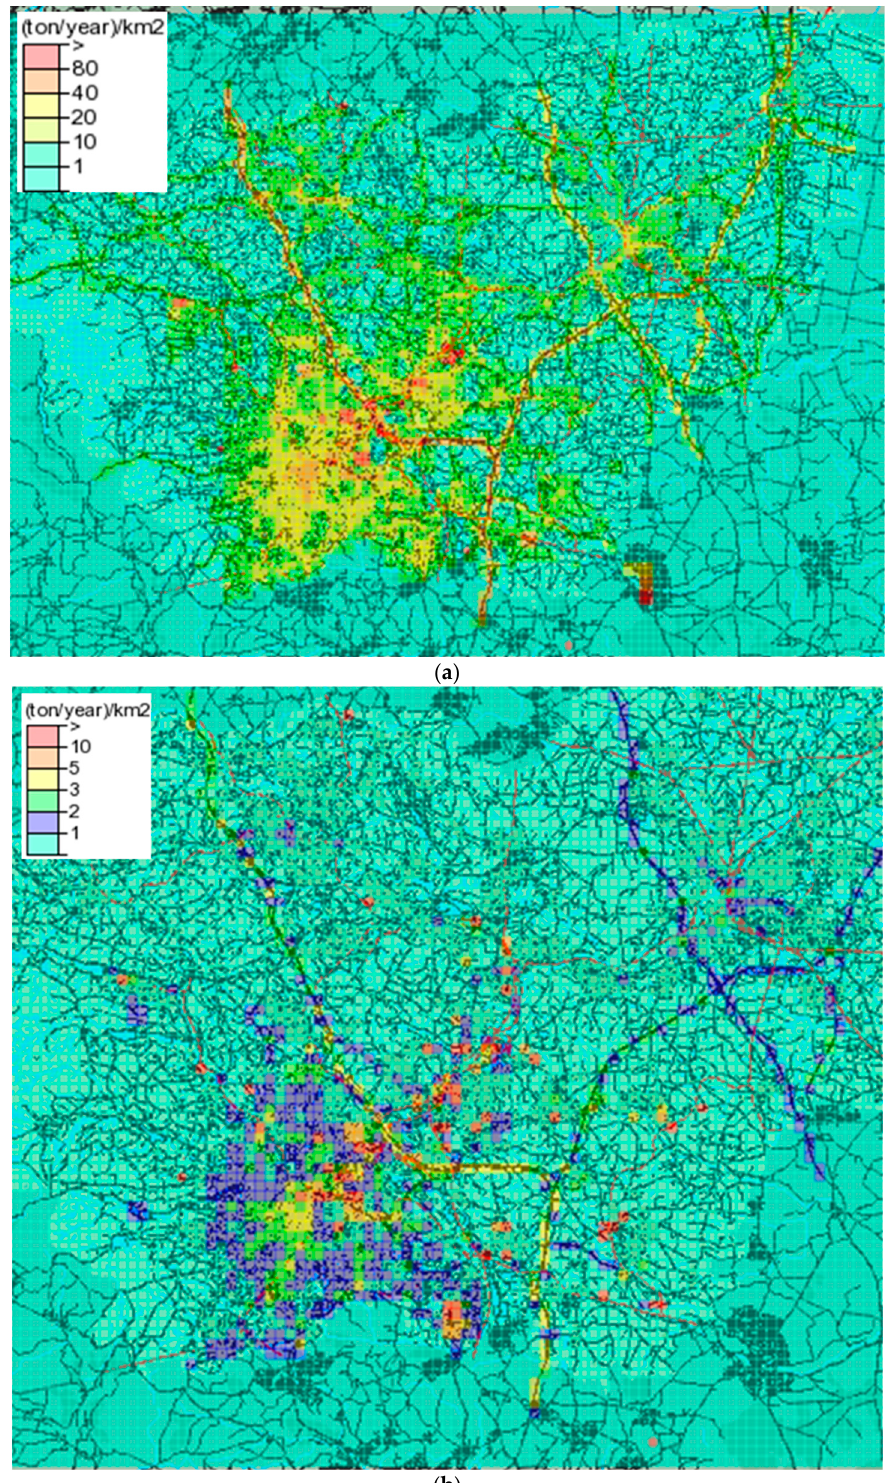
Figure 3. Emissions’ strength ((ton/year)/km 2 ) in Sheffield and surrounding areas including Rotherham for the year 2017 from all emission sources: ( a ) NOx emissions, ( b ) PM 10 emissions. Hourly meteorological data including temperature, relative humidity and wind speed and direction (Figure 4) were measured at Woodburn Road weather mast in She ffi eld, located at She ffi